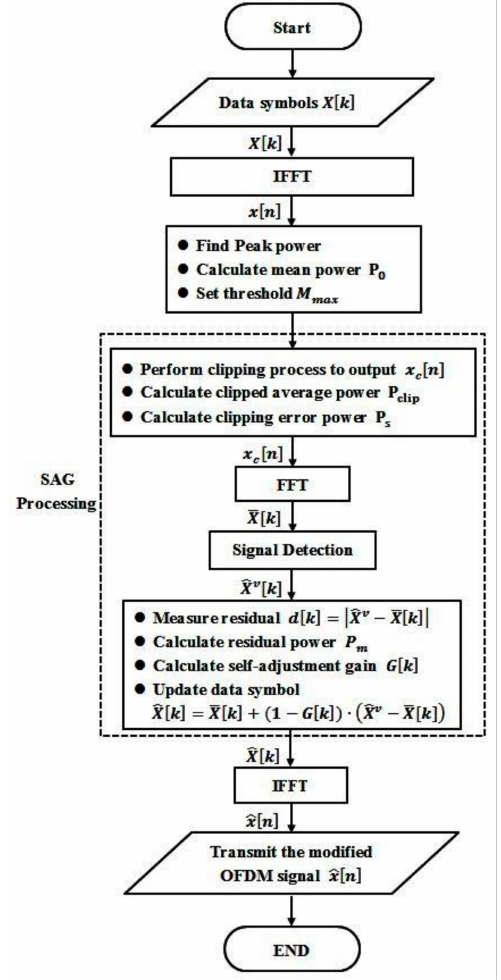
Figure 5. Flowchart of the proposed SAG